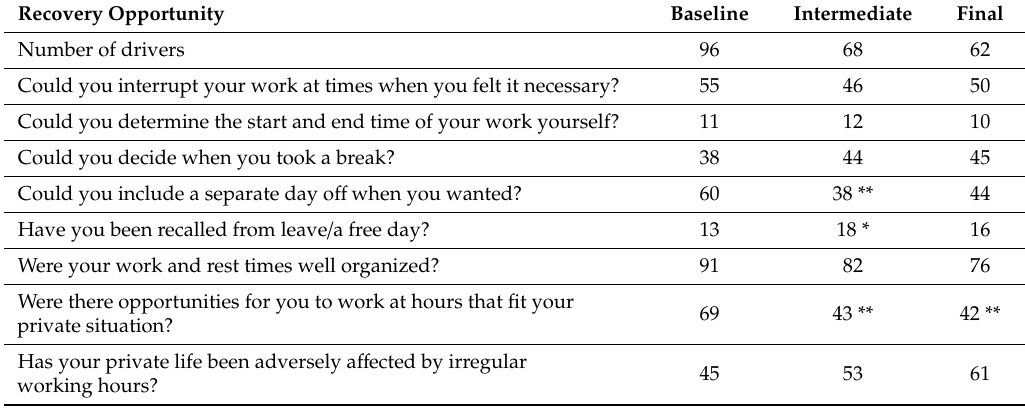
Table 4. Percentage of drivers that answered “yes” on the corresponding questions on recovery opportunities.